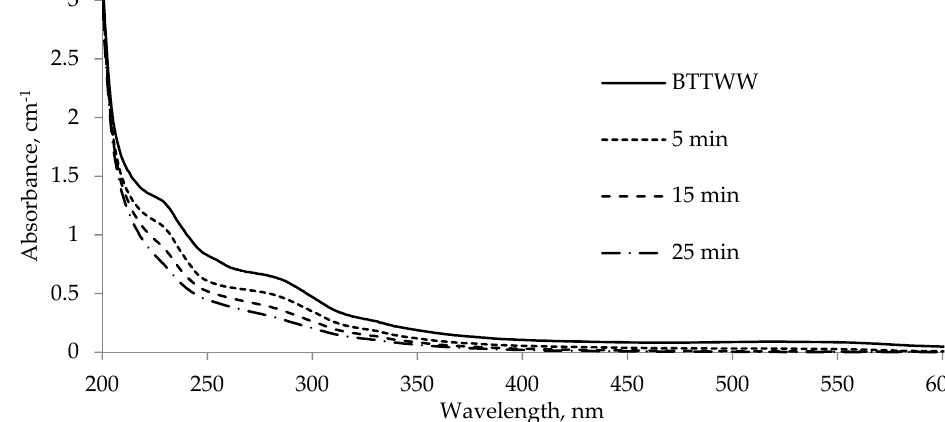
Figure 3. BTTWW color and absorbance values change with respect to ozonation time. It was also observed that percentage of unreacted ozone leaving the reactor decreased with prolonged reaction time. While 23.3% of the ozone gas left the reactor unreacted at 25 min, it was 34.6% at 5 min (Figure 4). At 25 min reaction time, approximately 1000 mg/L ozone reacted with BTTWW, achieving 40% COD and 15% TOC removal rates. Although the highest removal rates were achieved at 25 min, 15-min ozonation achieved sufficient color removal such that its effluent is safe to feed to the BPMED process.